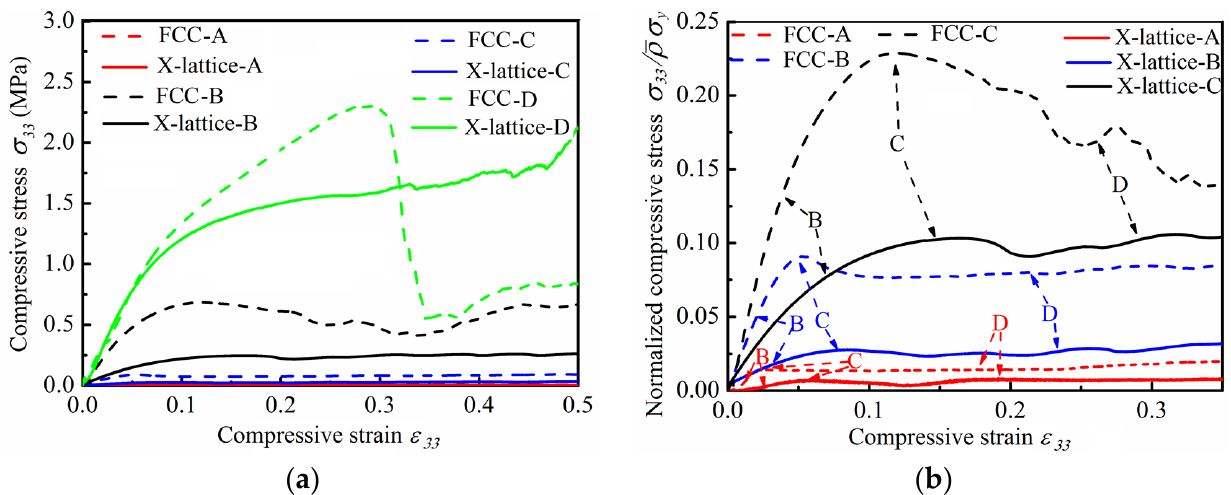
Figure 5. ( a ) Stress–strain curves of micro-architectures with variable relative density; ( b ) the normalized stress–strain curves of micro-architectures.